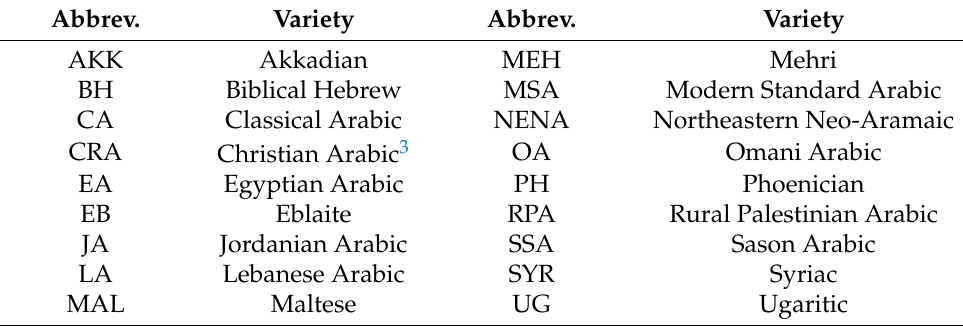
Table 1. Data tag